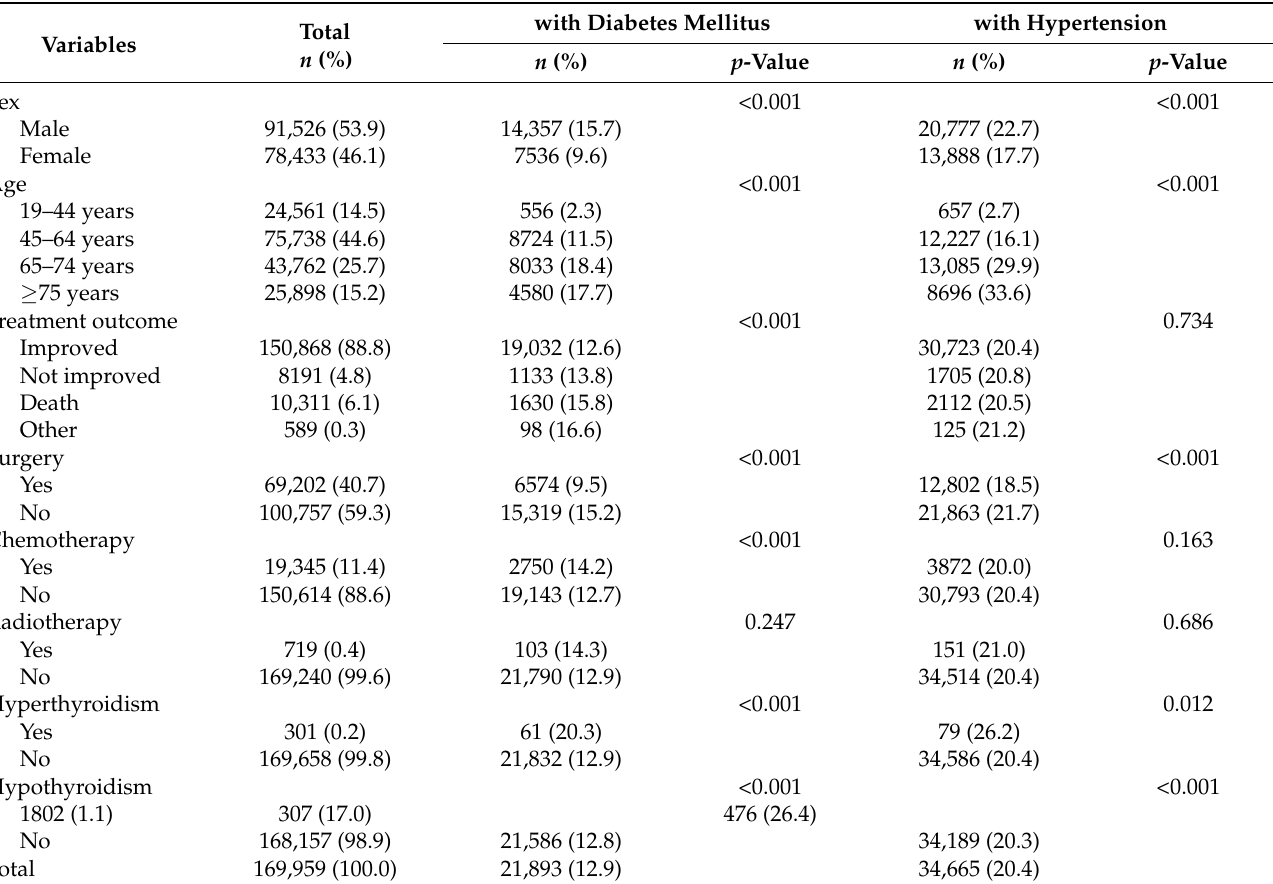
Table 1. Baseline characteristics of patients with cancer and concurrent diabetes or